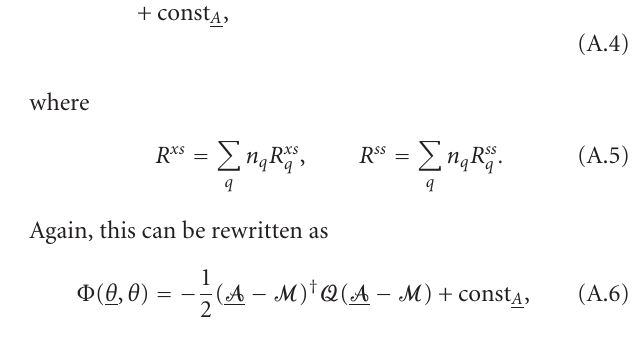
Figure 8: Comparison of the mean squared errors on the estima- tion of the emission law of dust as a function of noise in five di ff er- ent configurations: wSMICA without mask, wSMICA with mask, fSMICA without mask, and fSMICA with mask, and fSMICA with Hanning apodizing window.